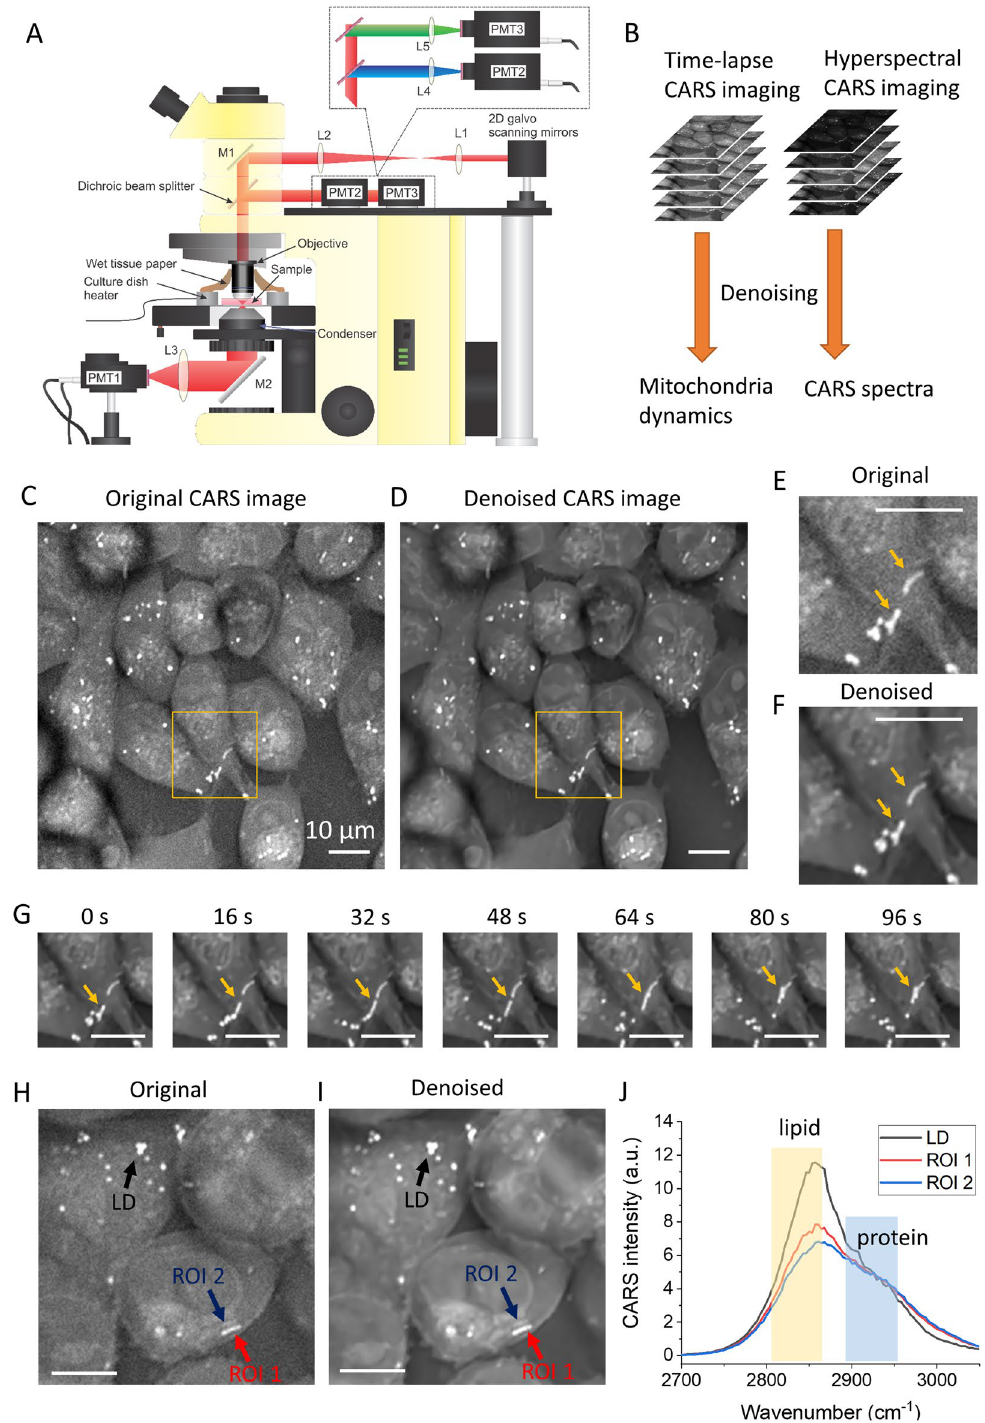
Figure 1. Discovery of fatty-acid-accumulated mitochondria in living cancer cells during hypothermia exposure. ( A ) Schematic of the CARS/MPEF hybrid microscope. ( B ) Illustration of denoising for hyperspectral and time-lapse image stacks. ( C ) An original CARS image at CH 2 vibration frequency from MIAPaCa-2 cells after hypothermia exposure. ( D ) Denoised CARS image in panel ( C ). ( E , F ) Magnified areas indicated by the yellow boxes in panels ( C , D ), respectively. ( G ) Time-lapse image of the selected area in panel ( D ). Yellow arrows in panels ( E – G ) point to FA-accumulated mitochondria structures. ( H , I ) are the original and the denoised images of fixed MIAPaCa-2 cells after hypothermia exposure. Different arrows point to different targets and regions of interest (ROIs) in these images. ( J ) The original CARS spectra obtained from the hyperspectral imaging. The yellow and blue bars highlight the lipid CH 2 and protein CH 3 vibrational regions, respectively. PMT photomultiplier tube, M mirror, L lens. Scale bars represent 10 µm and apply to all images. Panel ( J ) is generated by Origin